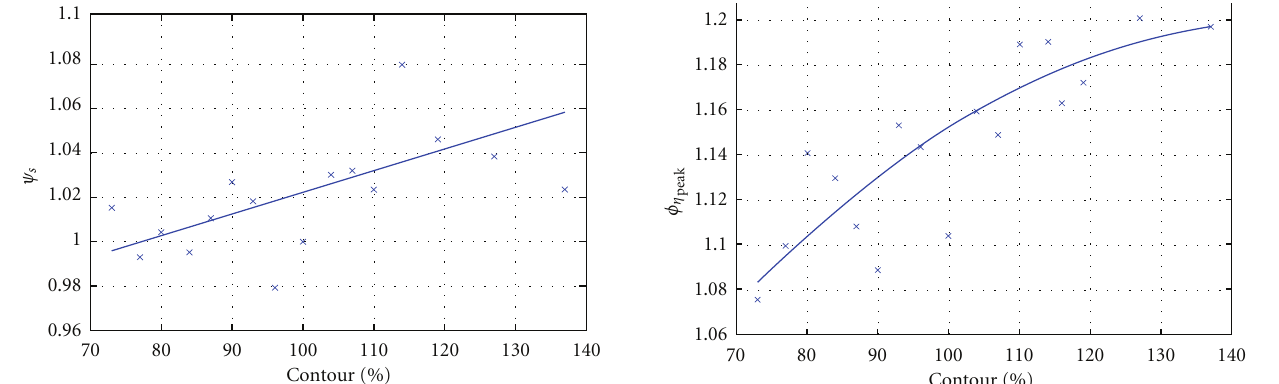
Figure 22: Flow coe ffi cient at the peak e ffi ciency versus the flow contours.